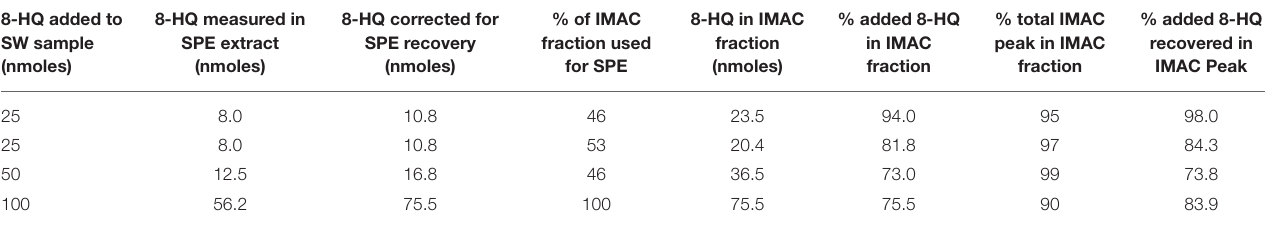
TABLE 1 | Recovery of the model ligand 8-hydroxyquinoline (8-HQ) from seawater by immobilized copper(II)-ion affinity chromatography (IMAC) and solid-phase extraction (SPE).